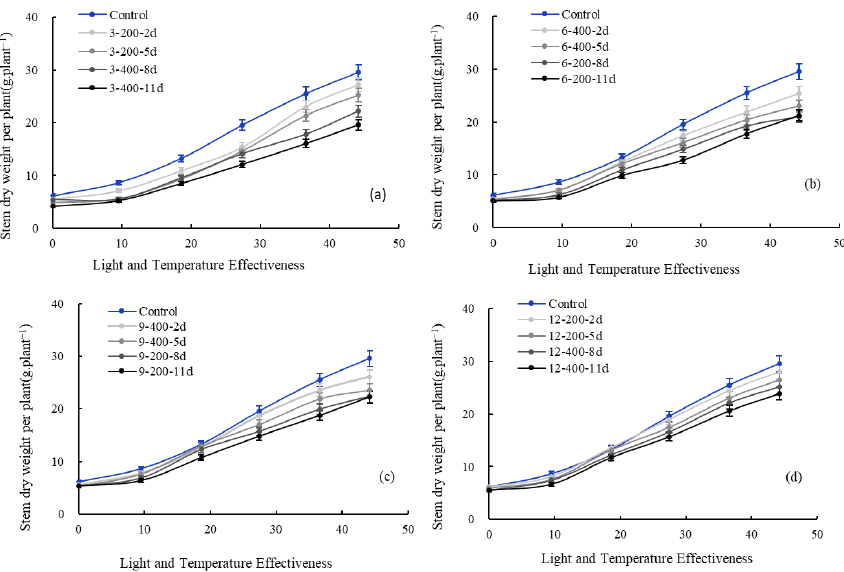
Figure 5. Variation trend of stem dry weight per plant of cucumber under LT and PL stresses. ( a ) Changes in dry weight of single cucumber stems with LTE under 3 °C treatments. ( b ) Changes in dry weight of single cucumber stems with LTE under 6 °C treatments. ( c ) Changes in dry weight of single cucumber stems with LTE under 9 °C treatments. ( d ) Changes in dry weight of single cucumber stems with LTE under 12 °C treatments. Note: Control represents the variation in stem dry weight per cucumber plant with the increase in LTE under normal growth conditions.